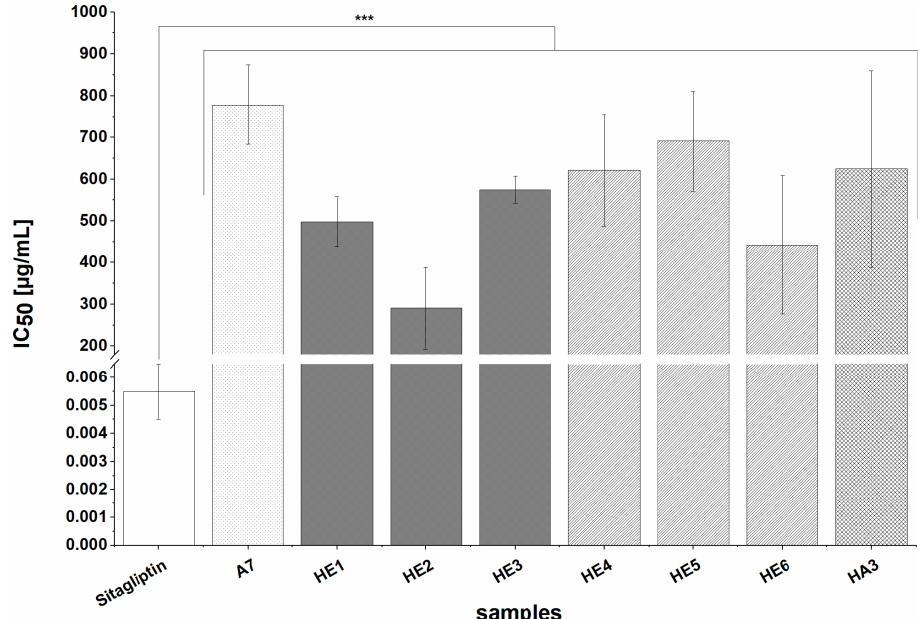
Figure 4. IC 50 values for the inhibition of DPP IV by extracts (A7, HE1-HE6, HA3) and the positive control (PC) agent Sitagliptin. Values are expressed as means ± SD of three to five independent experiments and 35 independent experiments for the PC, each performed in triplicate; significant differences from the PC are indicated by *** p < 0.001.